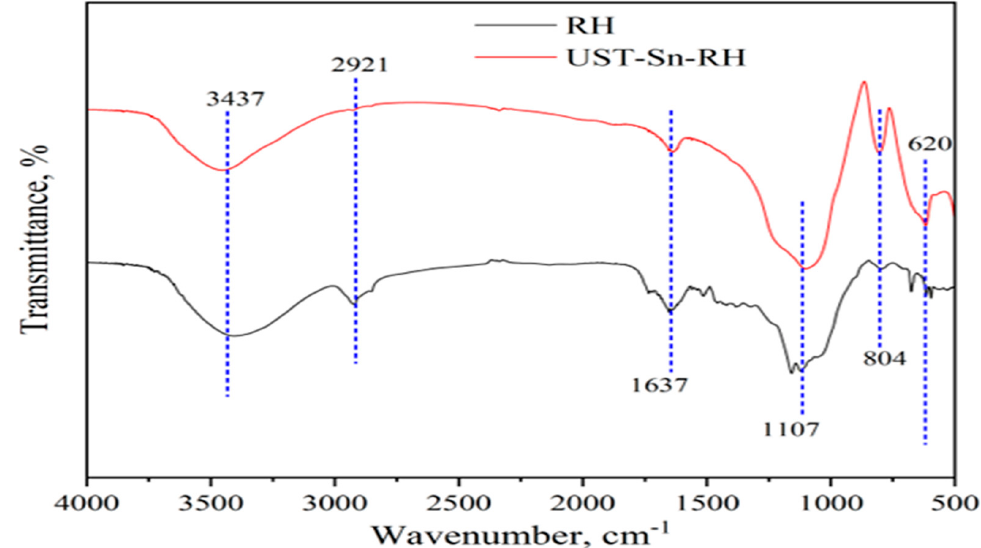
Figure 3. Fourier transform infrared spectroscopy (FT-IR) images of chemocatalyst UST-Sn-RH. FT-IR was conducted by using Nicolet IS50 (Thermo Scientific, Waltham, MA, USA) in the range of 4000–500 cm − 1 .